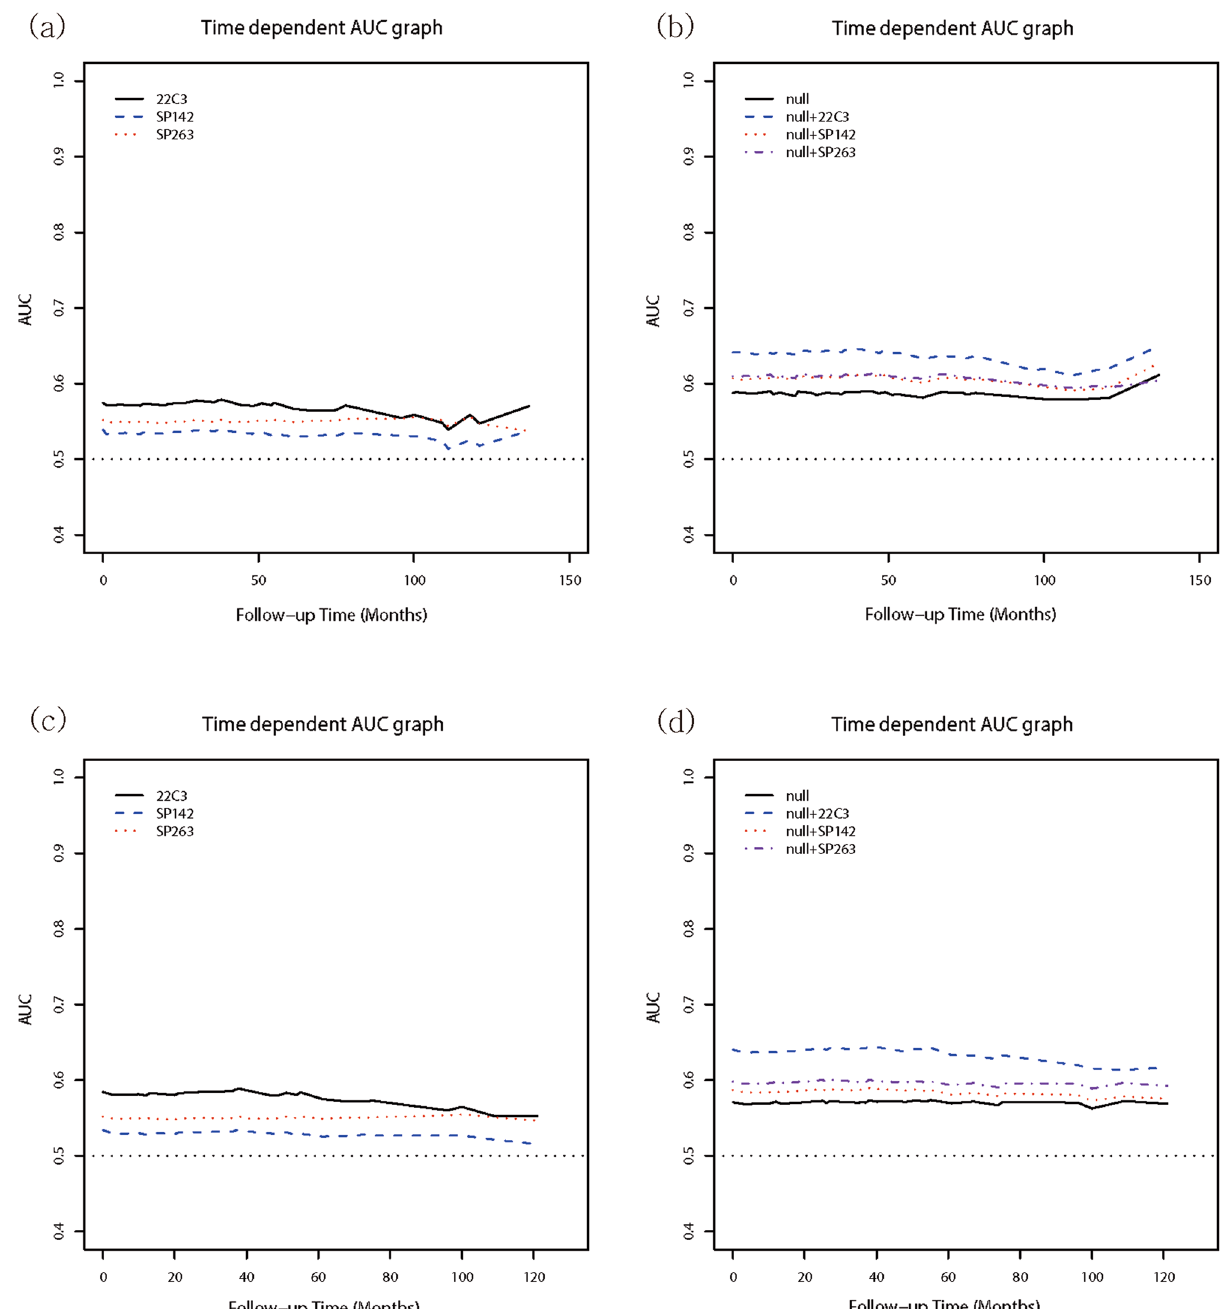
Figure 5. Comparison of improved discriminatory performance for each PD-L1 antibody using the time- dependent AUC graphs of RFS and DMFS. ( a ) Among the three PD-L1 antibodies, 22C3-IHC staining showed a higher AUC value in RFS. ( b ) Via addition to the null model in RFS, the improved AUC value based on the 22C3-IHC assay was observed to be superior among the three PD-L1 antibodies (AUC of 22C3 = 0.636, AUC of SP142 = 0.606, AUC of SP263 = 0.606). ( c ) Among the three PD-L1 antibodies, 22C3-IHC staining demonstrated a higher AUC value for DMFS. (d) Via addition to the null model in DMFS, the improved AUC value based on the 22C3-IHC assay was found to be superior among the three PD-L1 antibodies (AUC of 22C3 = 0.634, AUC of SP142 = 0.584, AUC of SP263 =